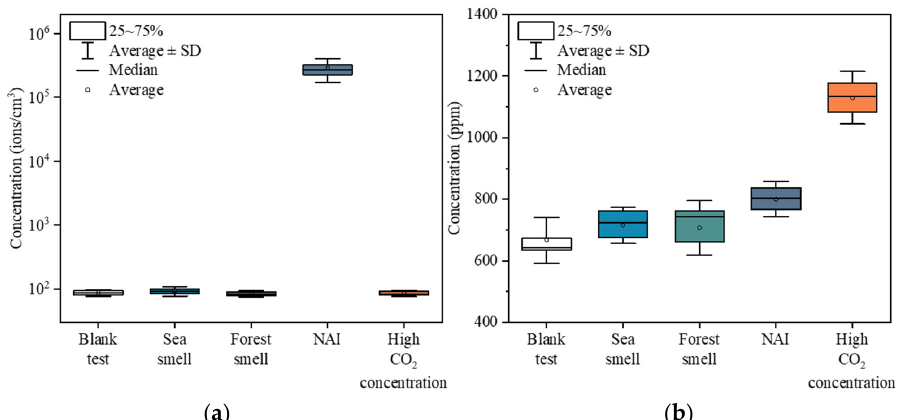
Figure 9. The air quality control during the four scenarios and blank test, ( a ) concentration of NAI and ( b ) concentration of CO 2 .